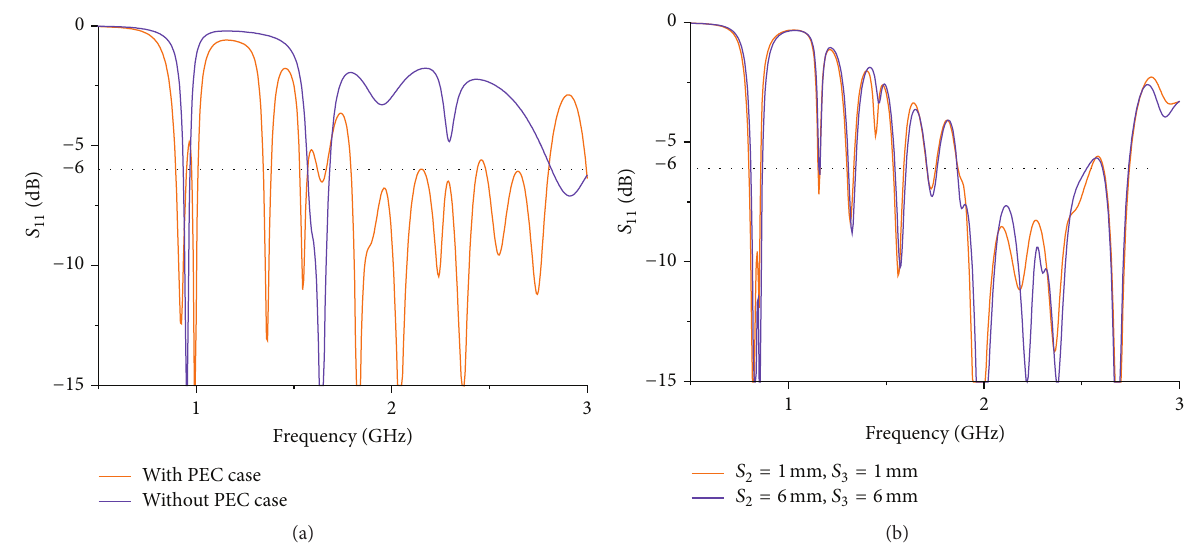
Figure 3: Effects on 𝑆 11 parameter: (a) PEC case and (b) variation in the lengths of 𝑆 2 and 𝑆 3 .